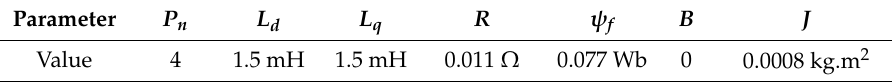
Table 5. Parameters of PMSM.